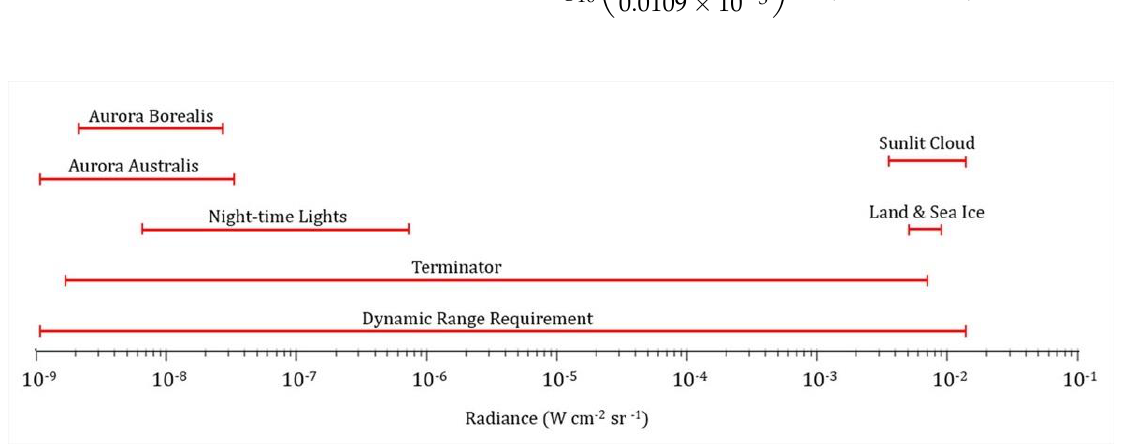
Figure 6. Radiance range comparison of the features that are desirable to radiometrically resolve and the resultant dynamic range required by a sensor to achieve